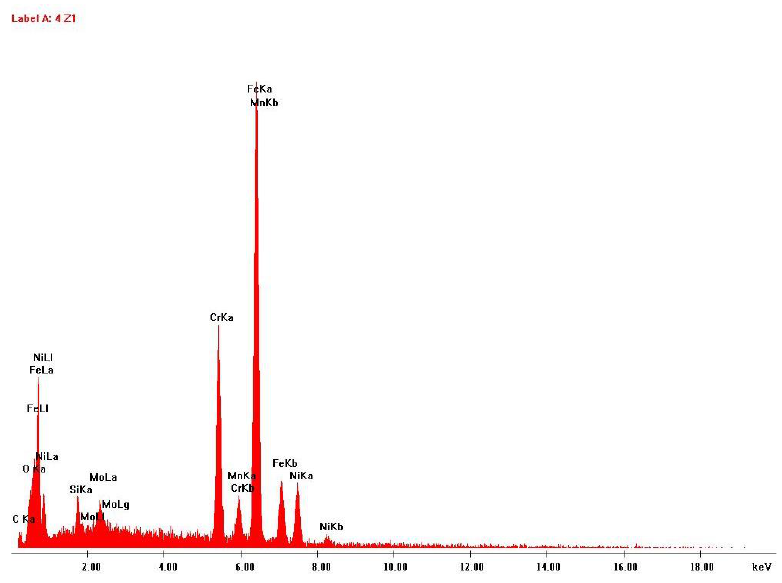
Figure 6. EDS analysis results: Stainless steel 316L powder after printing.